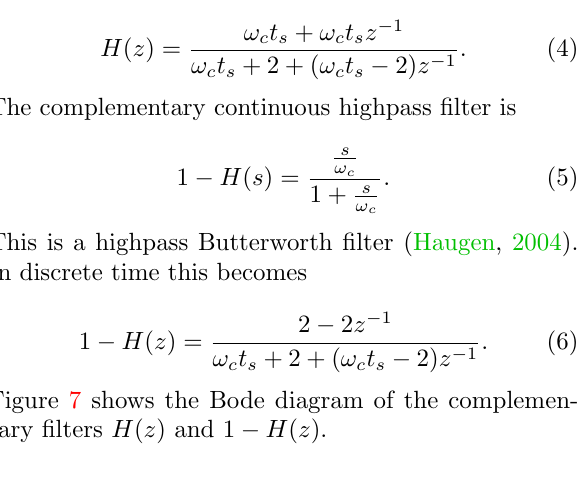
Figure 6: The silicon pyrometer, ˆ T s , shown in the time domain, after removing the 15 lowest fre- quency components.